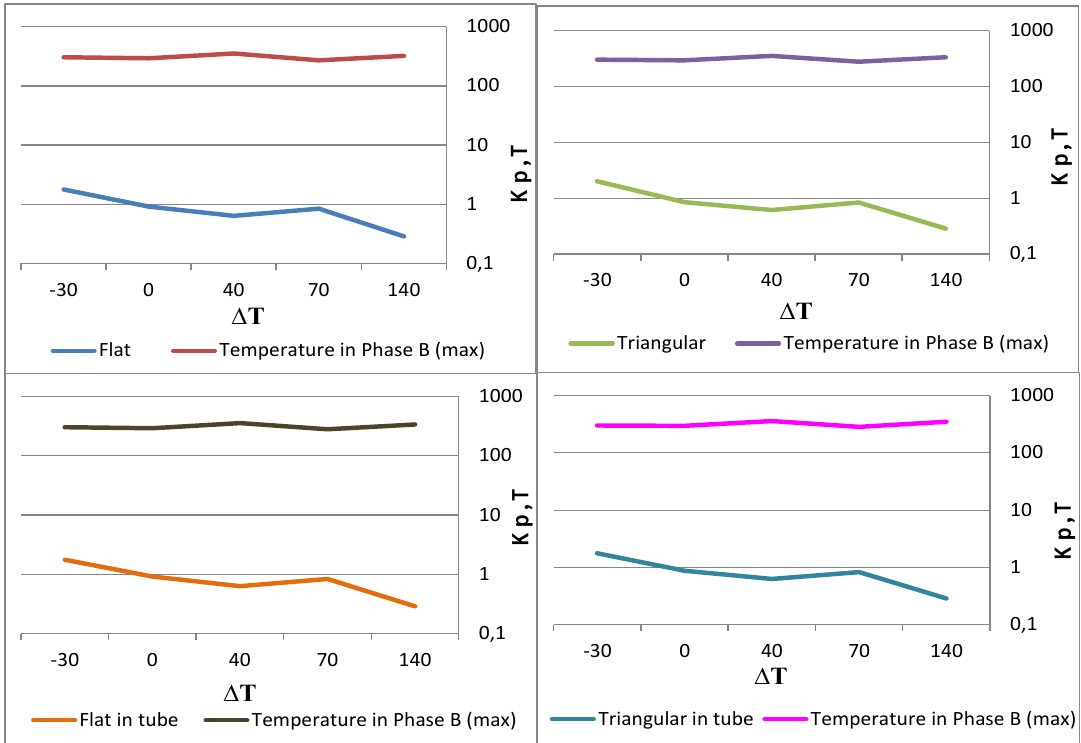
Figure 13. Comparison of the correction factor and the maximum phase B temperature for different cable layouts on a logarithmic